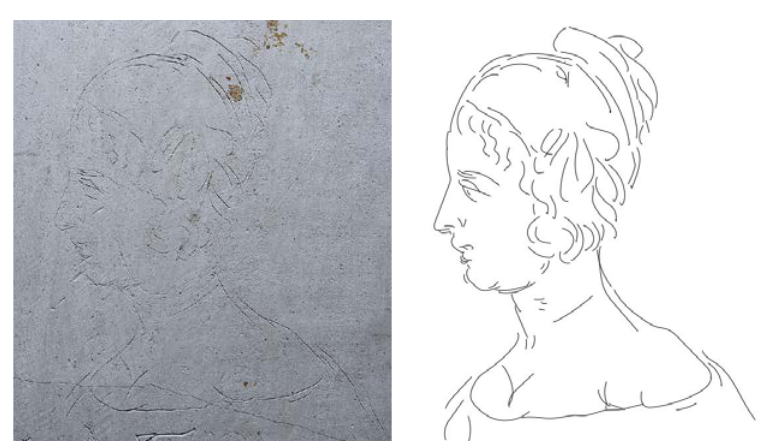
Figure 6 – The graffito of the head of a lady (photograph and tracing). Photo by Manuele Marraccini; tracing by Manuele Marraccini, Maria Chiara Moro and Sebastian De